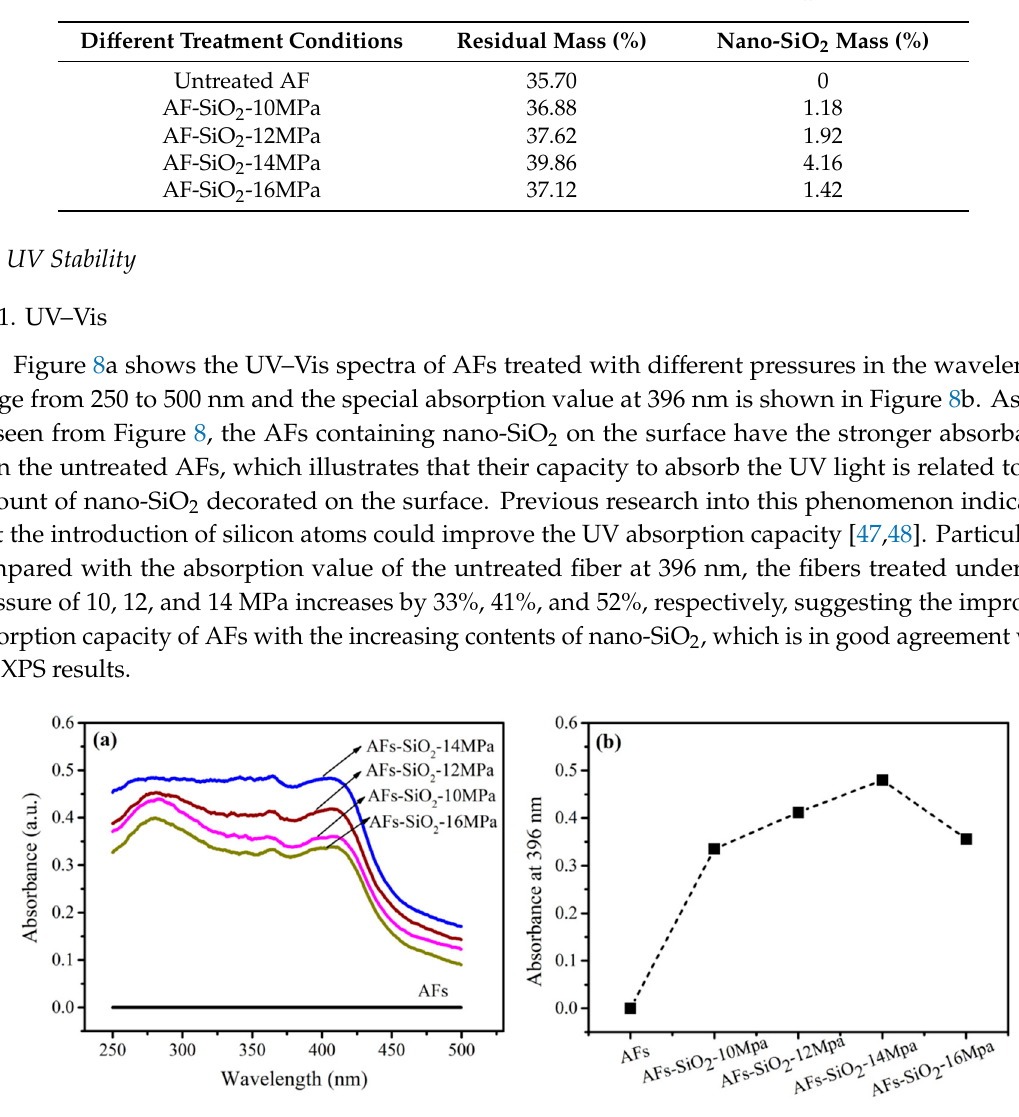
Figure 9. Mechanical properties of AFs and nano-SiO 2- modified AFs before ( a ) and after ( b ) 216 h of UV radiation. 3.5.3. Surface Compositions Figure 10 shows the C 1s core-level spectra of AFs and irradiated AFs. The components of untreated AFs shown in Figure 10a are divided into three peaks at 284.2, 285.7 and 287.8 eV, corresponding to the C–C, C–N and C=O bonds, respectively. After the UV radiation, a new peak